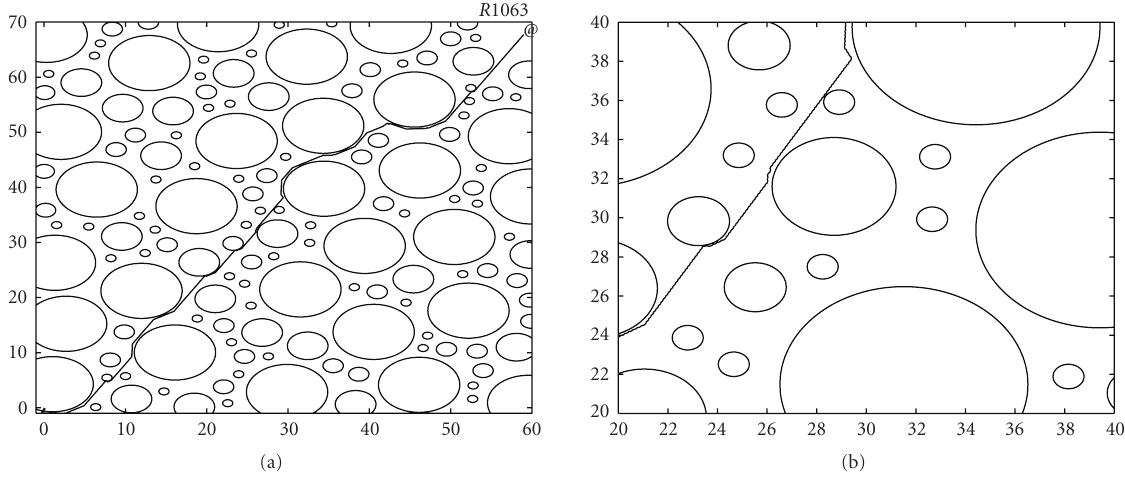
Figure 6: Motion planning for nonholonomic robots with multiple